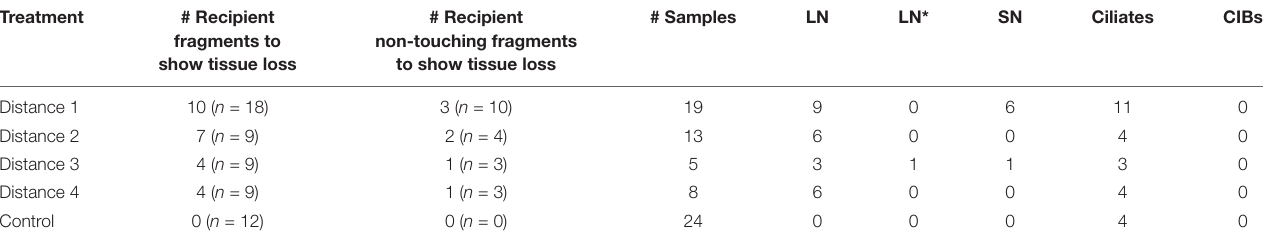
TABLE 2 | Histological samples examined from the M. cavernosa to Orbicella faveolata disease induction experiment. Treatment # Recipient fragments